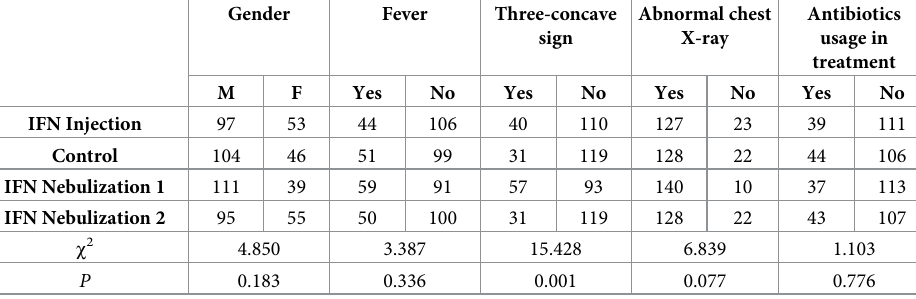
Comparison of differences in Lowell wheezing scores between different time points among the four groups indicated that the score difference between days 3 and 5 was statistically signif- icant, whereas the differences between days 1 and 3 and 5 and 7 were not (Table 8, p values were < 0.001, 0.165, and 0.149, respectively). Table 3. The comparison of baseline data by the chi-squared test.